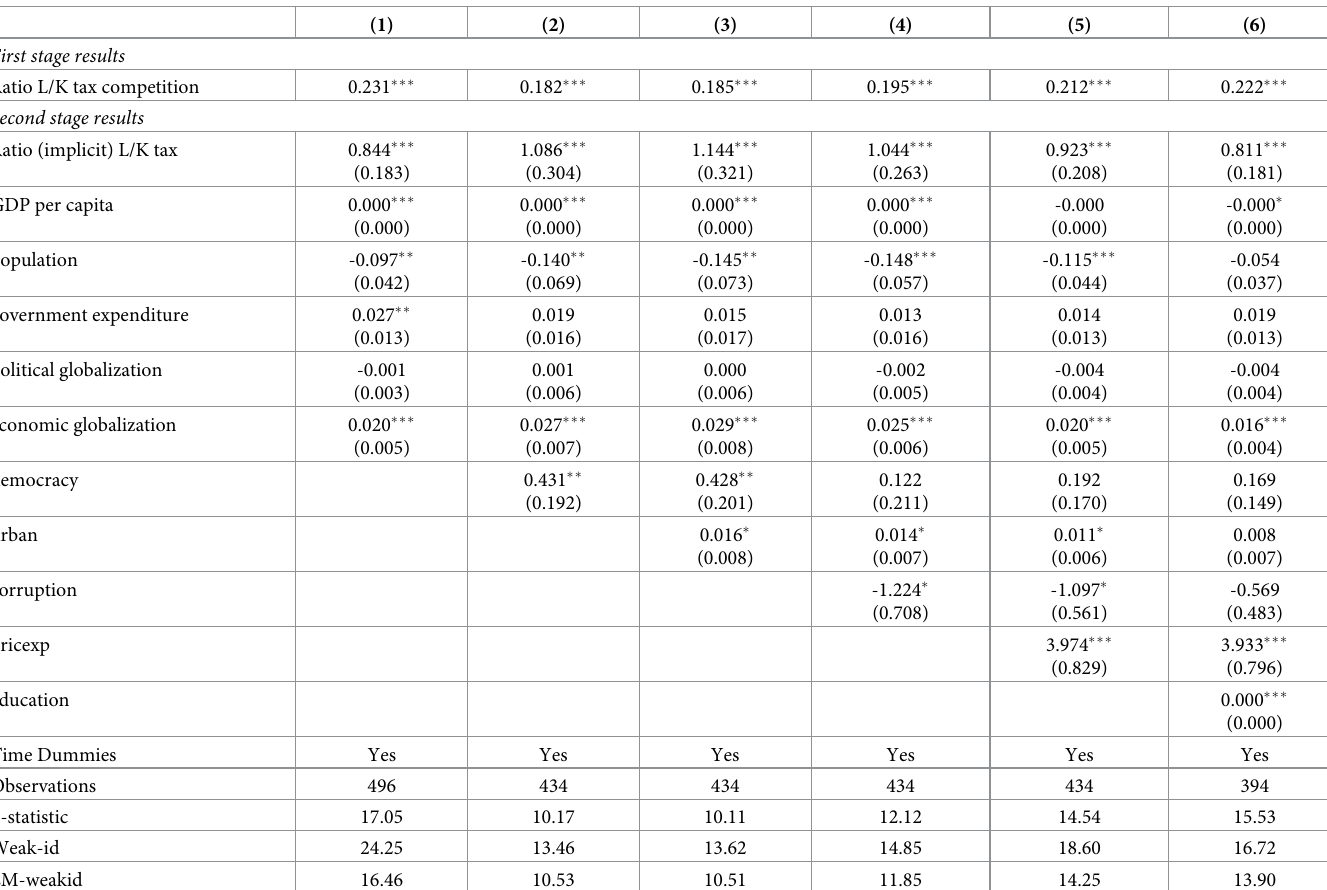
Table 6. The impact of taxation on economic sophistication: Ratio of (implicit) labor to (implicit) capital tax